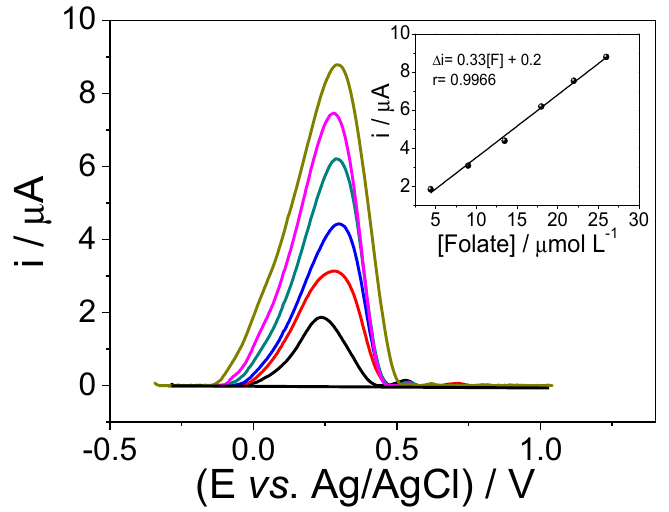
Figure 8. Electrochemical determination of folate by SWV using the mag-MIP/CPE sensor. Analysis conditions: 0.1 mol L − 1 acetate buffer solution (pH 4.0). SWV conditions: f = 15 Hz, a = 75 mV, Δ Es = 0.005 mV.